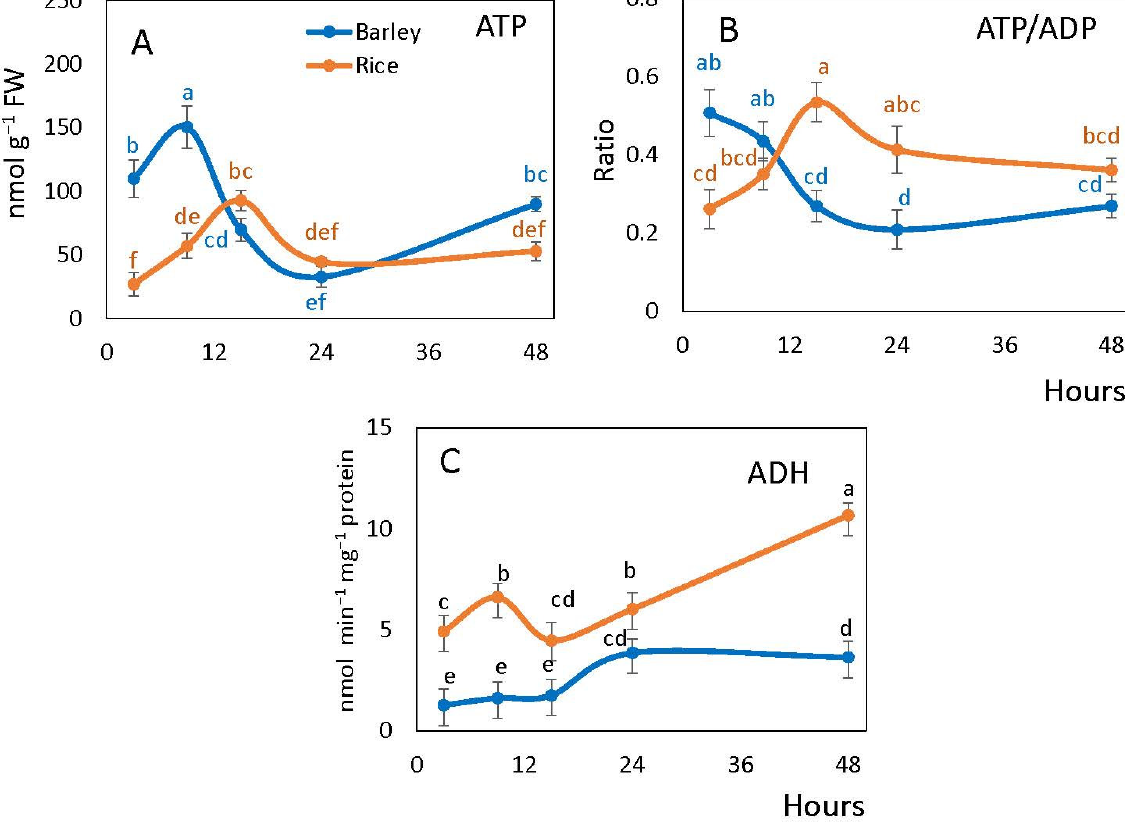
Figure 1. Germination of rice and barley seeds. Germination rates of two species within five days of imbibition. Vertical bars represent standard deviations ( n = 3). Different letters indicate significant differences between the two species and the time points at p < 0.05, (one-way ANOVA test, Tukey comparison).